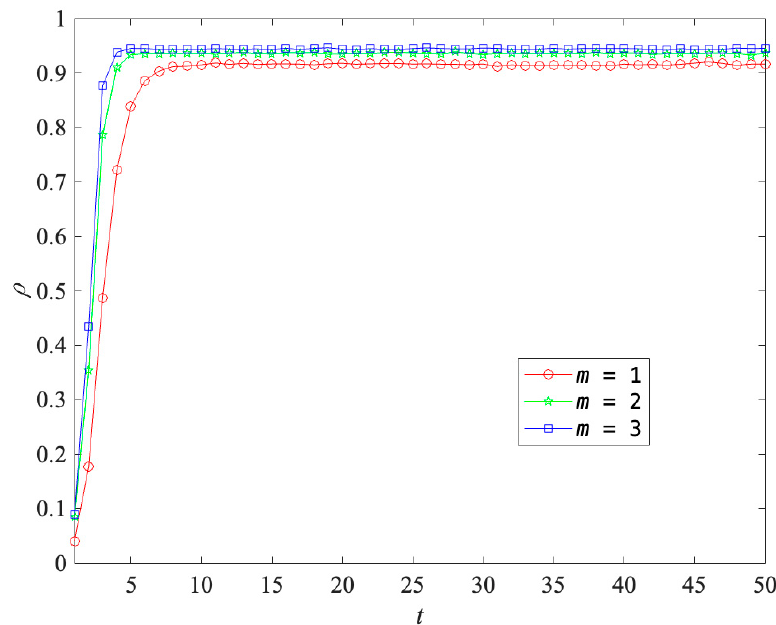
Figure 7. The simulated density of infected nodes ρ vs. time t for different numbers of hyperedges m .